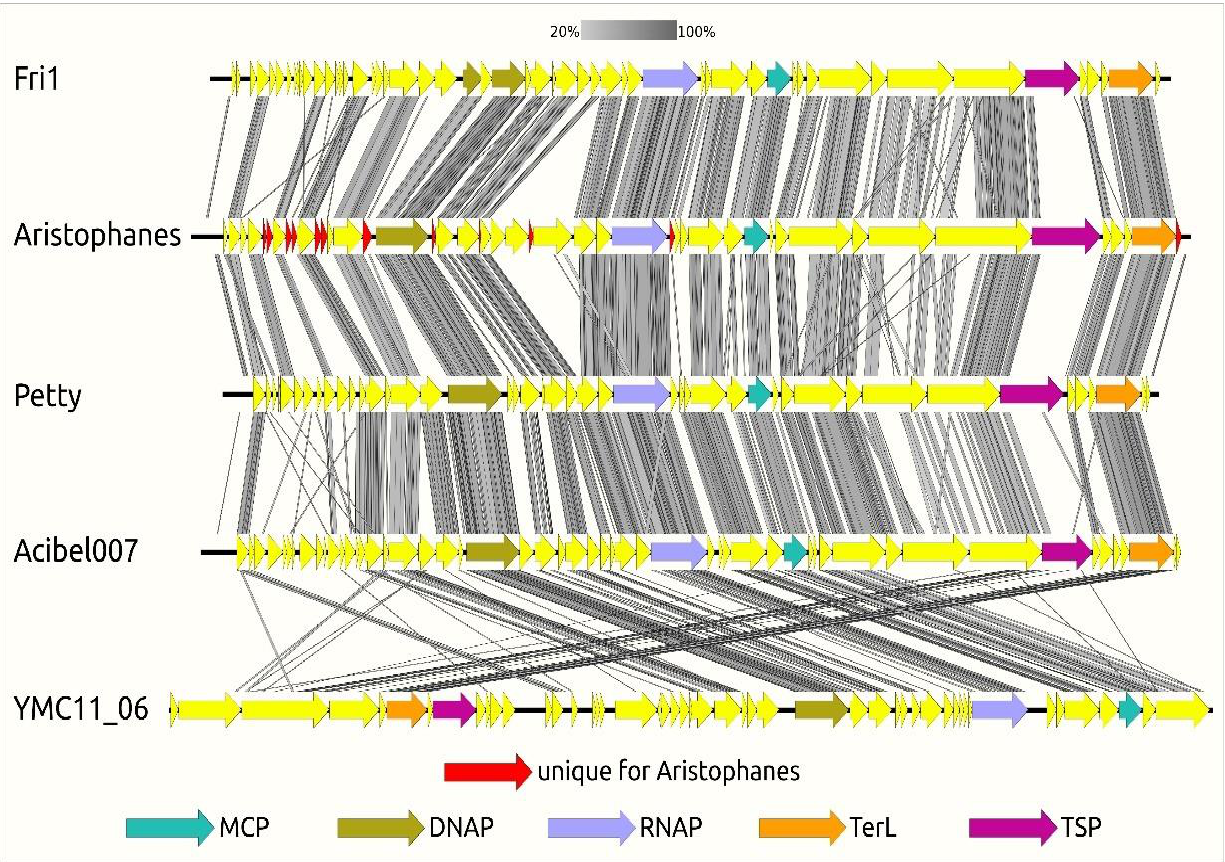
Figure 4. Genome sequence comparison among five Autographiviridae genomes exhibiting co-linearity detected by TBLASTX. The percentage of sequence similarity is indicated by the intensity of the grey colour. Vertical blocks between analysed sequences indicate regions with at least 20% similarity. Genes’ names are as follows: MCP, major capsid protein; DNAP, DNA-polymerase; RNAP, DNA-dependent RNA-polymerase; TerL, large subunit of terminase; TSP, tailspike protein; YMC11_06, abbreviated name of Pseudomonas phage YMC11/06/C171_PPU_BP.